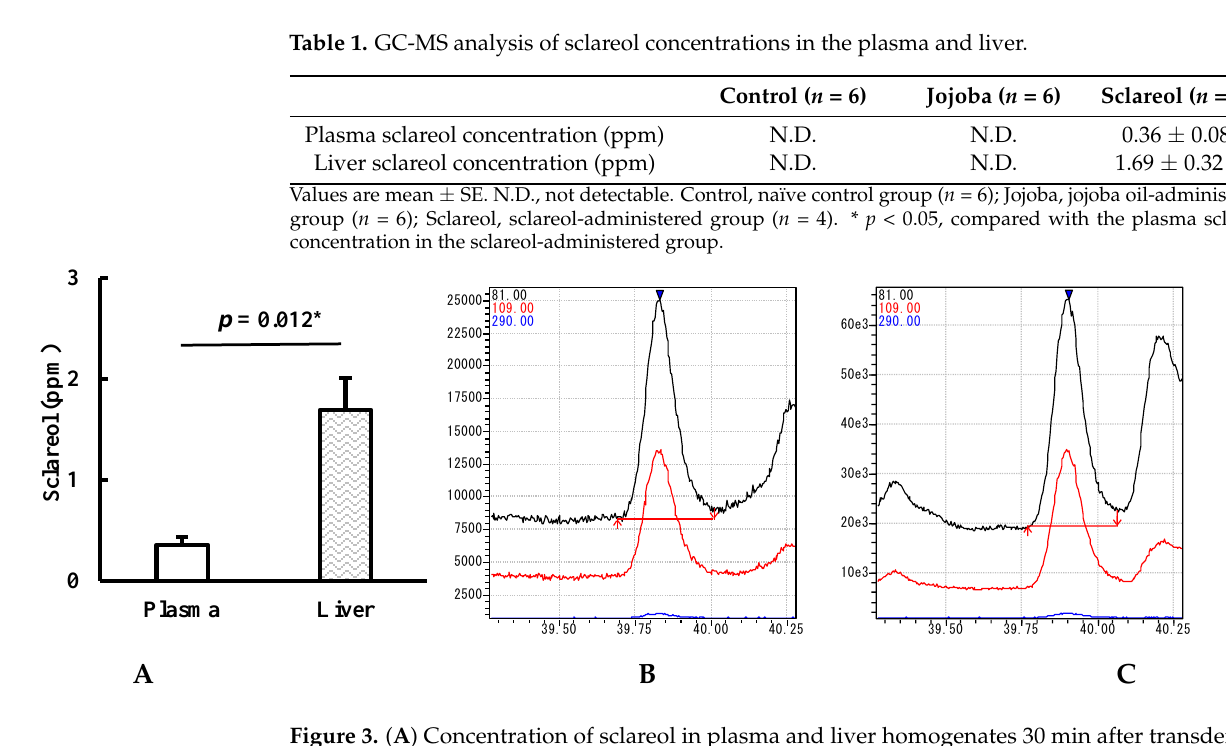
Figure 3. ( A ) Concentration of sclareol in plasma and liver homogenates 30 min after transdermal administration of sclareol in the sclareol-administered group. Values are presented as mean ± SE, n = 4. A paired t -test was performed using the SPSS 24.0 statistical software package. * p < 0.05. ( B ) Representative chromatograms of plasma concentrations of sclareol from the GC-MS analysis. ( C ) Representative chromatograms of sclareol in liver homogenates from the GC-MS analysis. We analyzed m / z 81, 109, and 290 in selected ion monitoring mode to quantify sclareol in plasma or liver homogenates ( m / z 81 was used for quantification). The retention time of the sclareol standard product analyzed in the scan mode was 39.8 min.